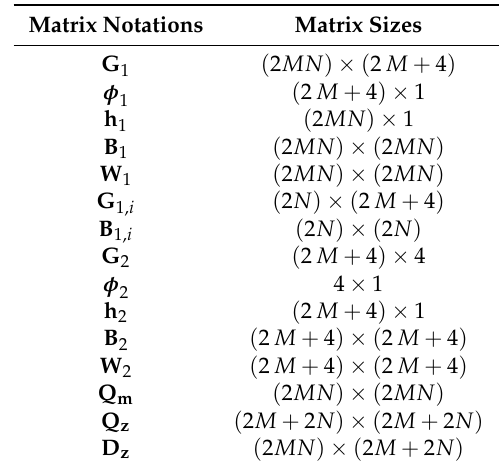
Table 3. Size of